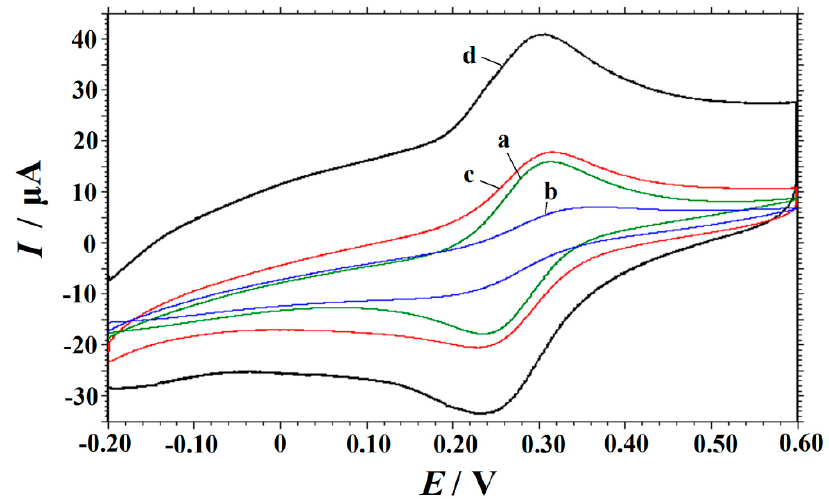
Figure 3. CVs of 1.0 mM K 3 [Fe(CN) 6 ] in 0.5 M KCl recorded at ( a ) GCE, ( b ) GO / GCE, ( c ) CeO 2 / GCE and ( d ) CeO 2 / ERGO / GCE at a scan rate of 0.1 V s − 1 .